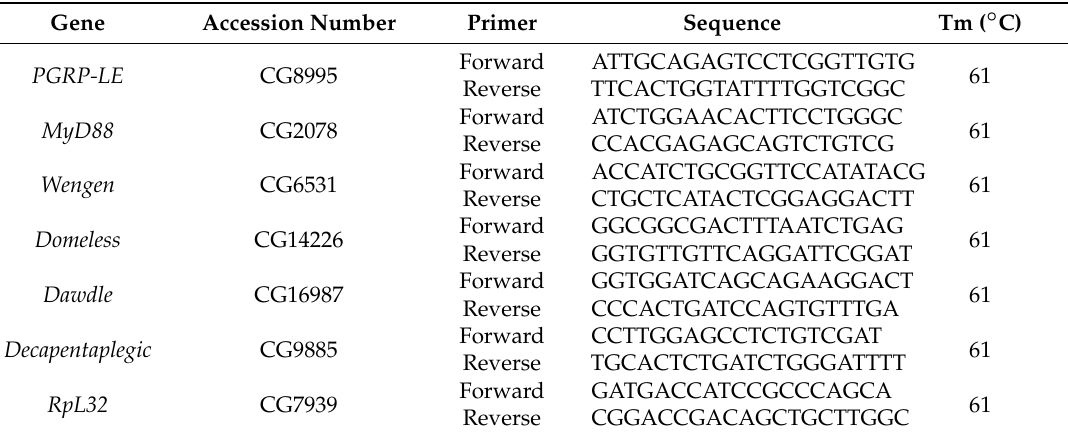
Table A2. Primer sequences used in quantitative RT-PCR